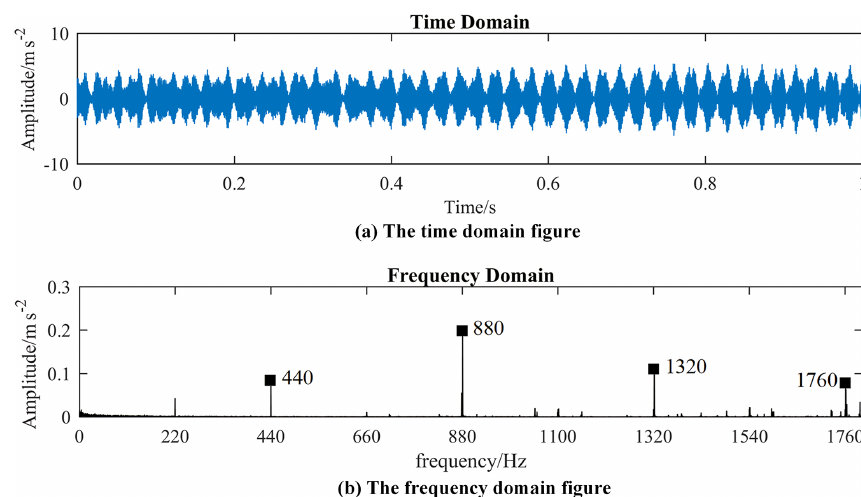
Figure 19. Vibration signal of the motorized spindle at 13200rpm.